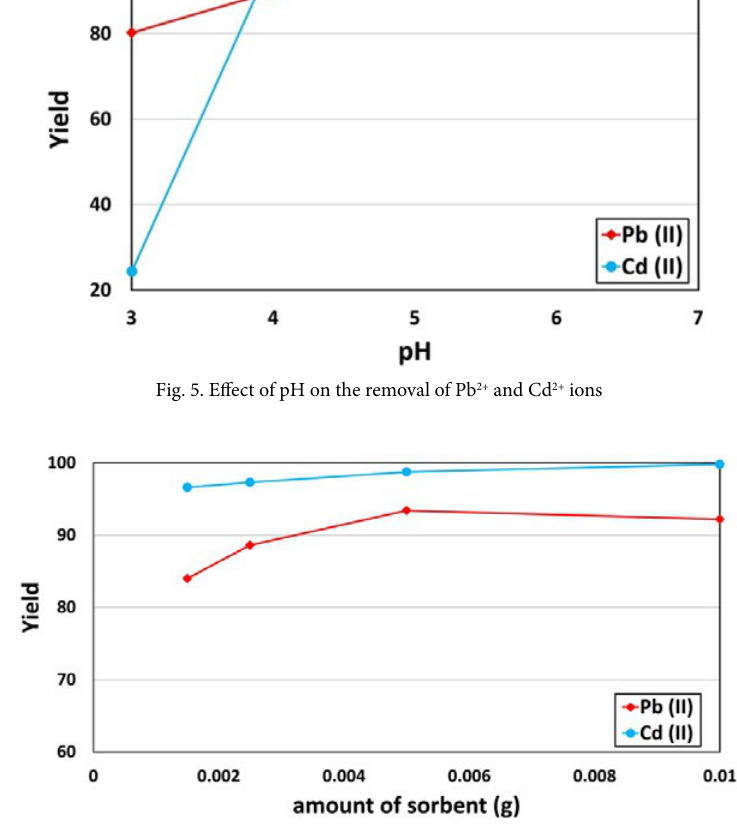
Fig. 6. Effect of sorbent dosage on the removal of Pb 2+ and Cd 2+ ions